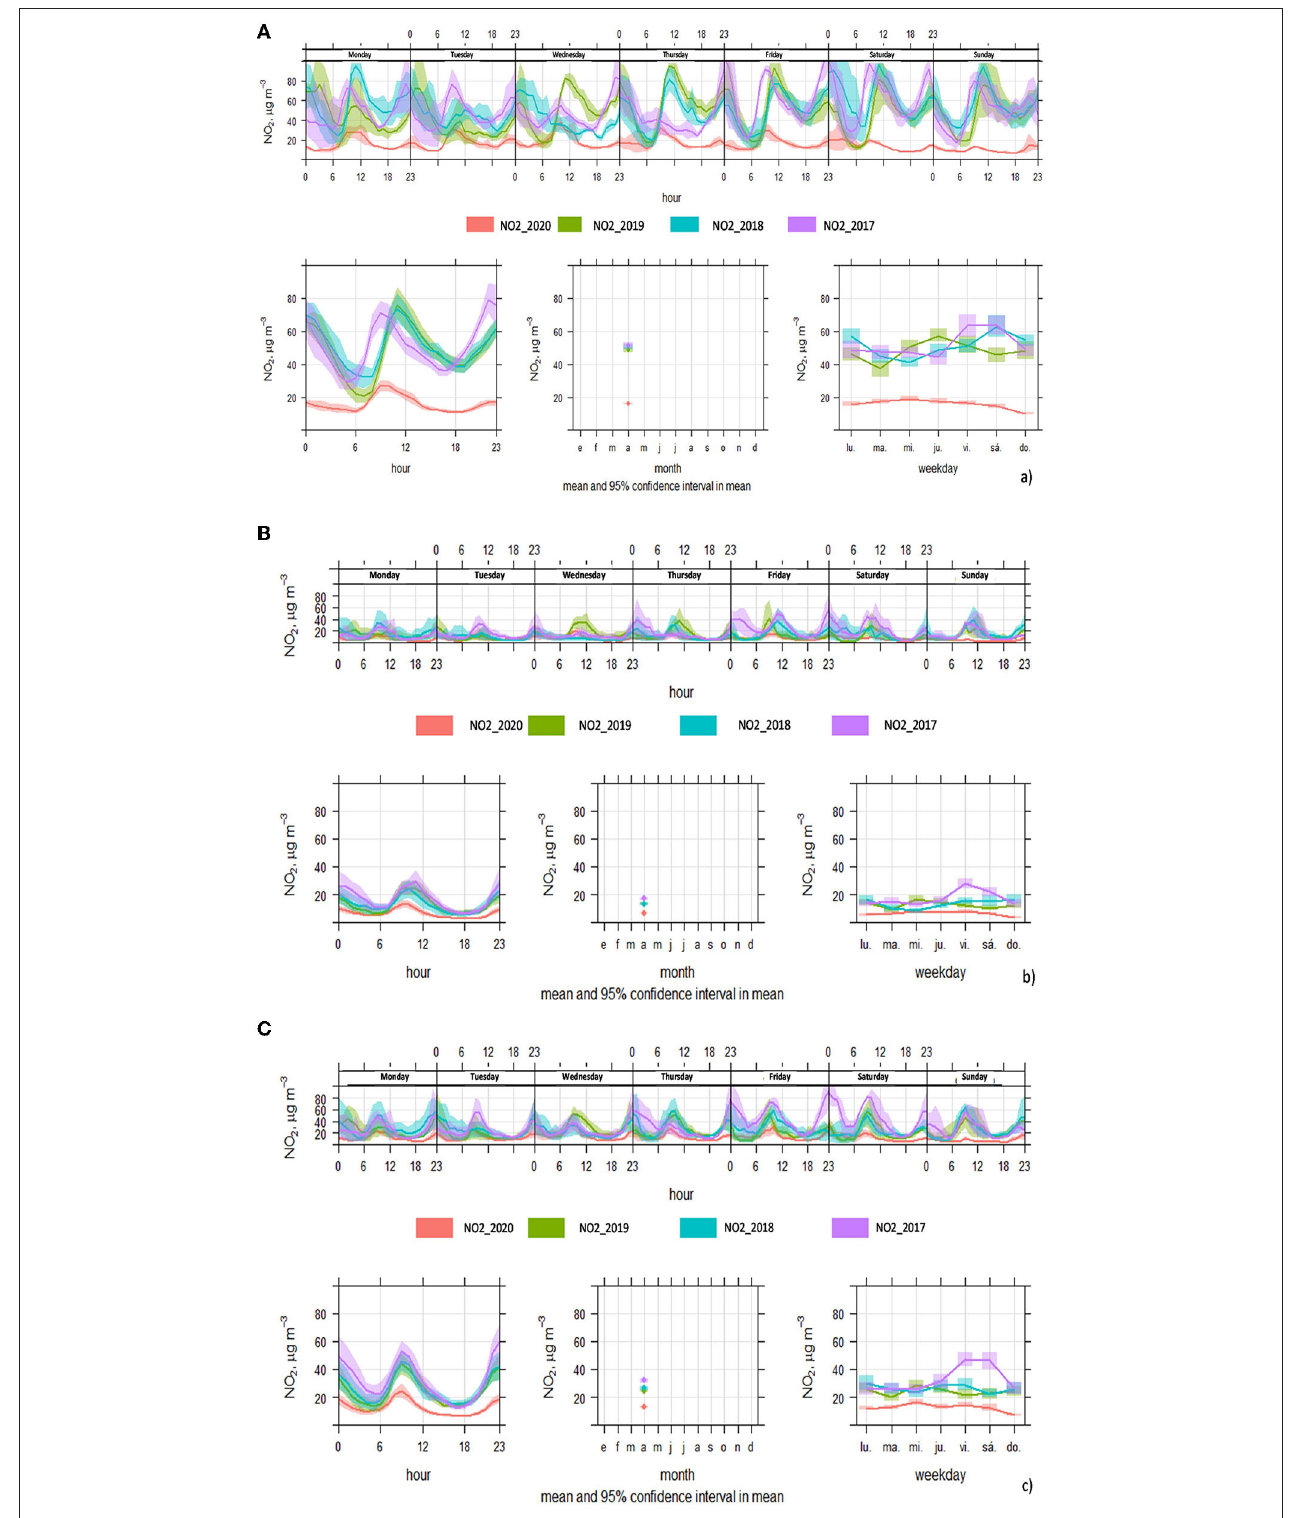
FIGURE 1 | The NO 2 time series for the consecutive months of April for three air quality station (AQS) representatives of each category: (A) Escuelas Aguirre: traffic, (B) Casa de Campo: suburban, and (C) Farolillo: background. The figure was made using the function timeVariation from the OpenAir R package (Carslaw and Ropkins,